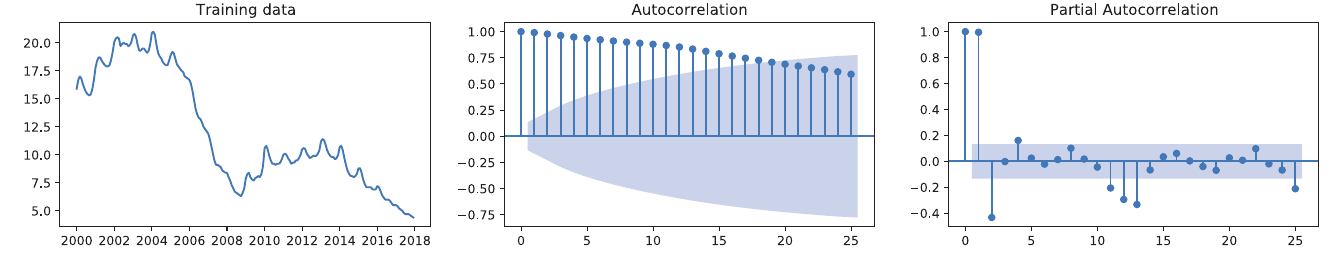
Figure 5. Training data, ACF and PACF plots for Poland.